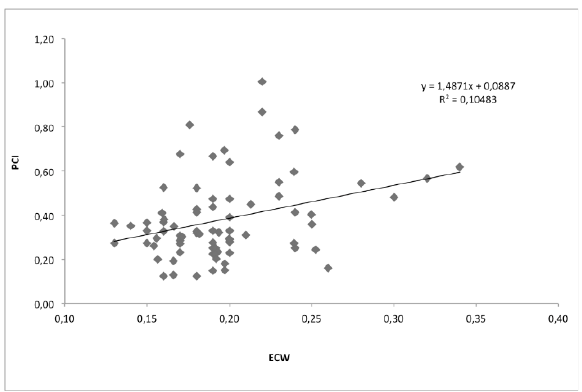
Figure 3: Correlation between PCI and ECW during treadmill walking test with 12% slope, (p=0.001).